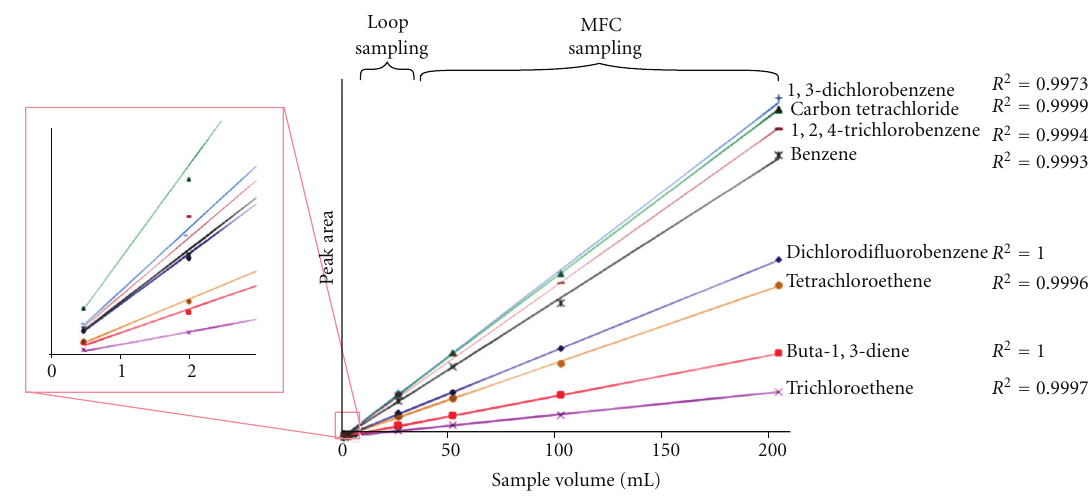
FIGURE 4: Responses for loop sampling (at 0.5 and 2 mL) and mass-flow-controlled sampling (at 25, 50, 100, and 200 mL) (CIA -Advantage system, Markes International Ltd) for selected compounds from the TO- 15 canister standard, showing that a single curve can be fitted to both sets of points (method conditions shown in Table